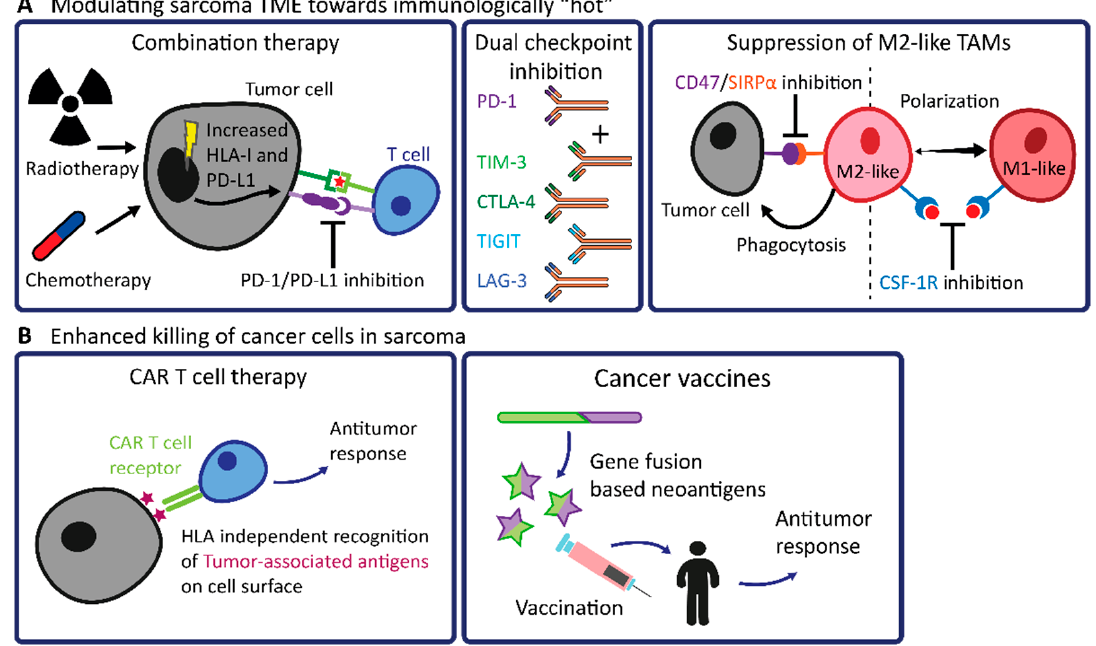
Figure 2. Overview of high-potential future therapeutic approaches for sarcomas with simple genomes or sarcomas with immunologically “cold” or excluded TME.